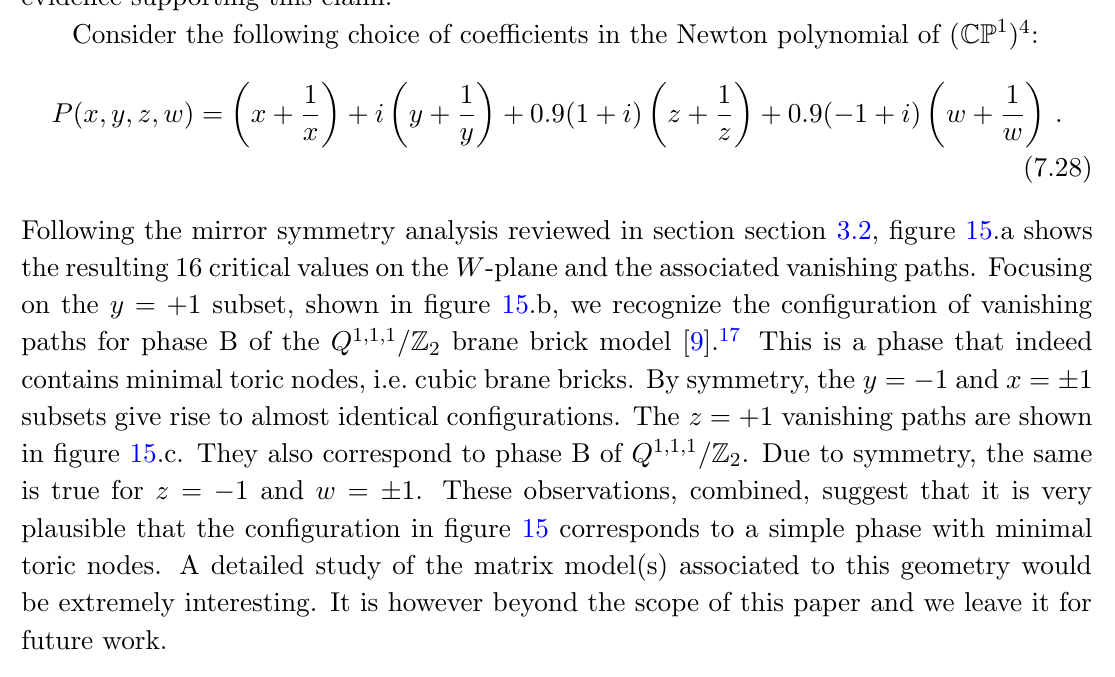
Figure 15 . Vanishing paths on the W -plane for a candidate phase of the local ( CP 1 ) 4 model. that local CP 1 (cid:2) CP 1 (cid:2) CP 1 (cid:2) CP 1 does the job for matrix models. Below we present some evidence supporting this